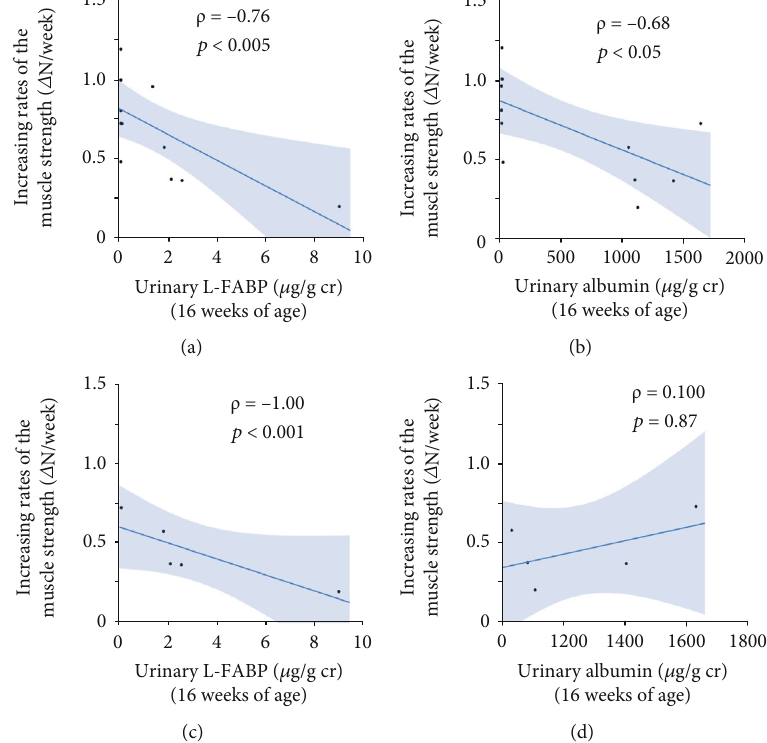
Figure 7: Correlations between each urinary marker at 16 weeks of age and increasing rate of muscle strength from 16 to 24 weeks of age in SD and SDT fatty rats (a, b). Correlations between each urinary marker and increasing rate of muscle strength from 16 to 24 weeks of age in SDT fatty rats (c,